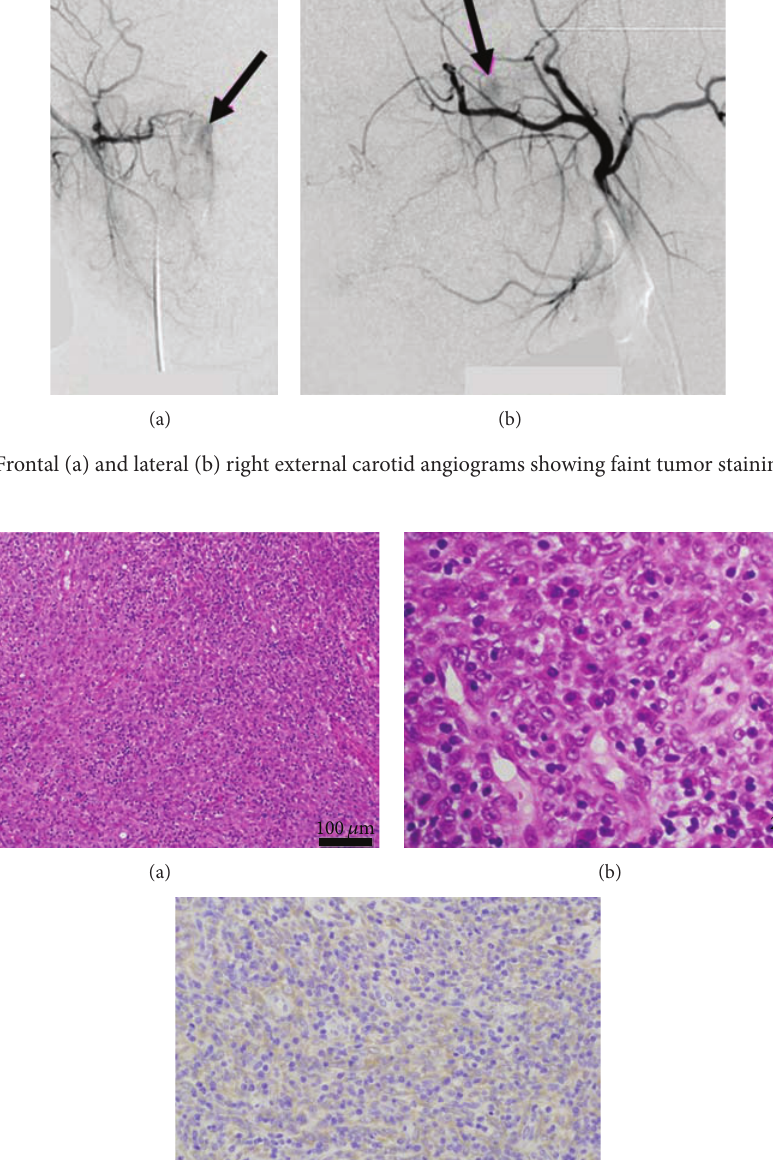
SMA (95.8%), desmin (69%), and cytokeratin (36%) [2].